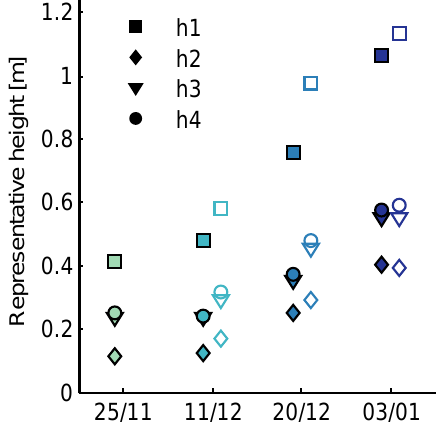
Figure 6. Representative surface heights computed on detrended surface meshes for site A (solid) and site B (open) over time, where h1–h4 refer to the representative surface heights computed as range ( h1 ), twice the standard deviation ( h2 ), area weighted mean height above the minimum ( h3 ) and area weighted median above the min- imum mesh height ( h4